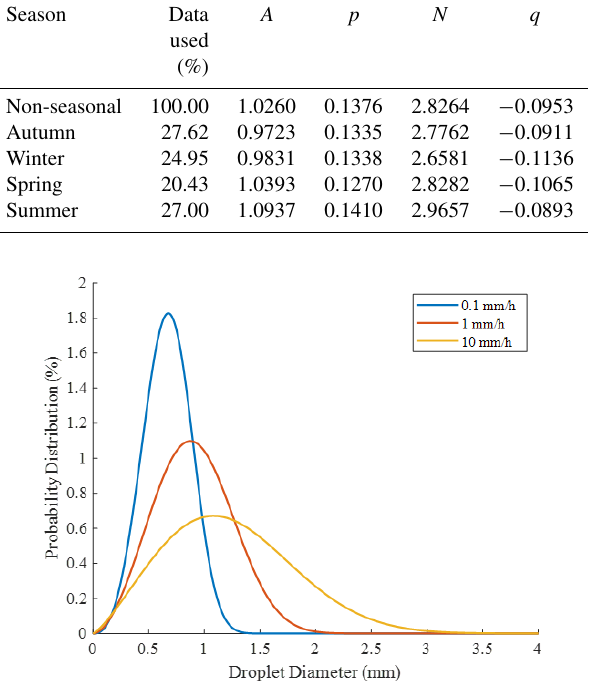
Figure 9. The non-seasonal offshore DSD at different precipitation intensities.